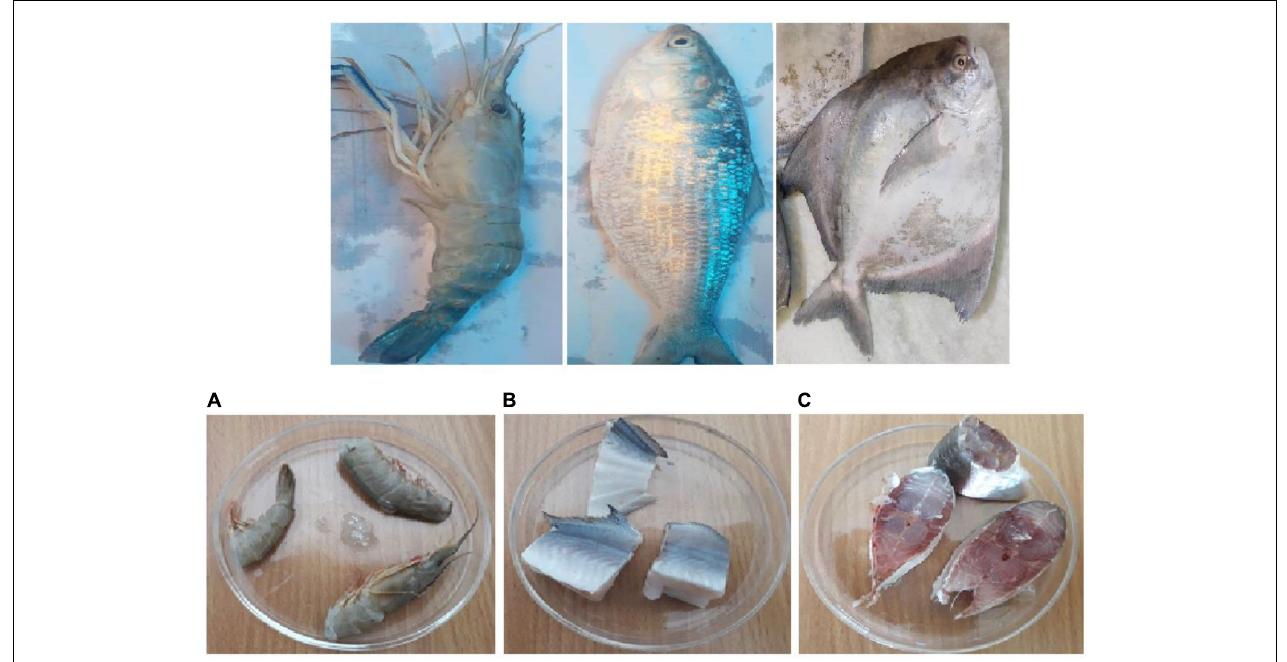
FIGURE 1 | Raw fresh shrimp and fish samples. (A) Penaeus merguiensis , (B) Pampus argenteus , and (C) Tenualosa ilisha